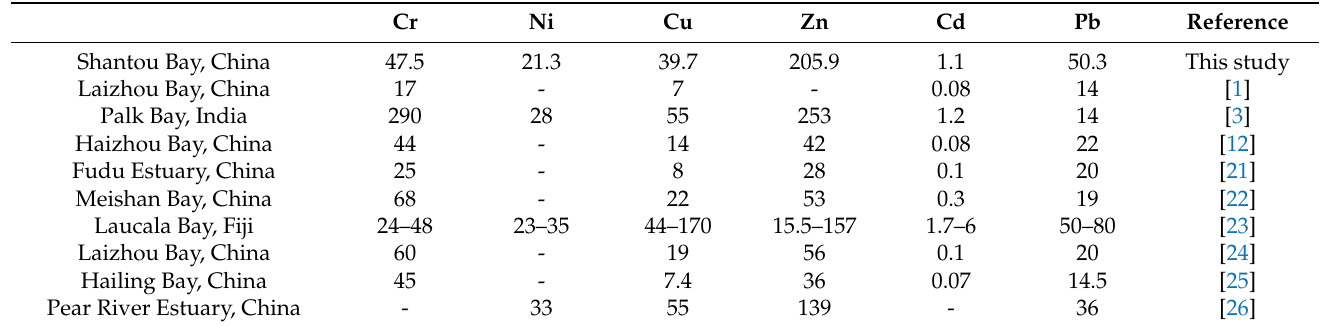
Table 2. Levels of heavy metals in sediments from different bays